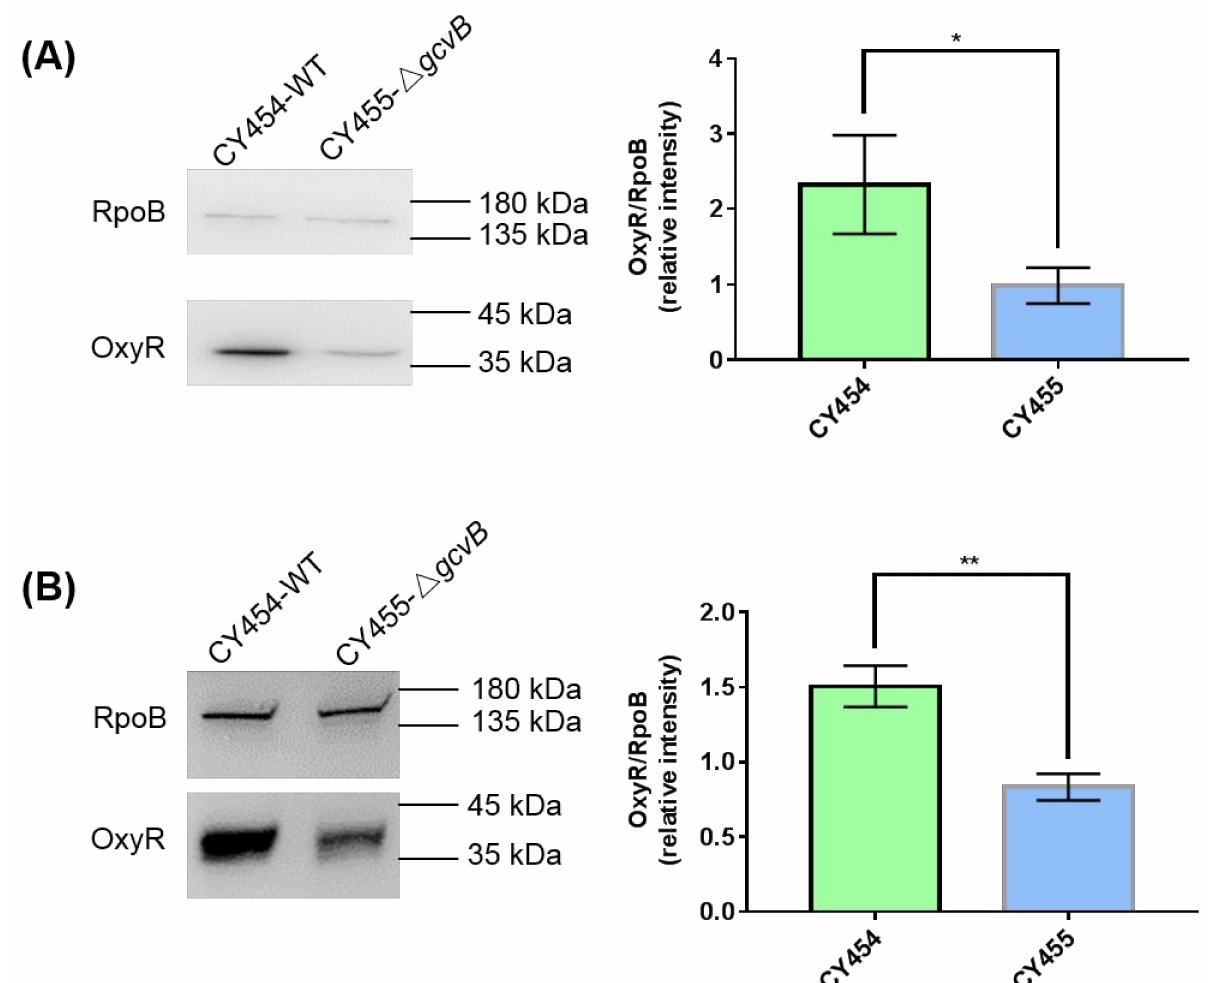
Figure 3. The protein levels of OxyR in the gcvB knockout and wild-type strains. The protein levels of OxyR in the gcvB wild-type strain CY454 and in the gcvB knockout strain CY455 cultured in LB rich medium ( A ) or in glucose minimal medium ( B ) were tested using Western blot. RpoB was applied as a loading control. The 0.025 OD 600 ( A ) or 0.05 OD 600 ( B ) cells were loaded. One representative result of six repeats in two independent Western blots is shown on the left. The relative protein level of three repeats in one Western blot is shown as the average ± S.D. on the right. The protein level of OxyR in CY455 was normalized to 1 and that in CY454 was determined relative to this value. ** p < 0.01, * p < 0.05 using Student’s t